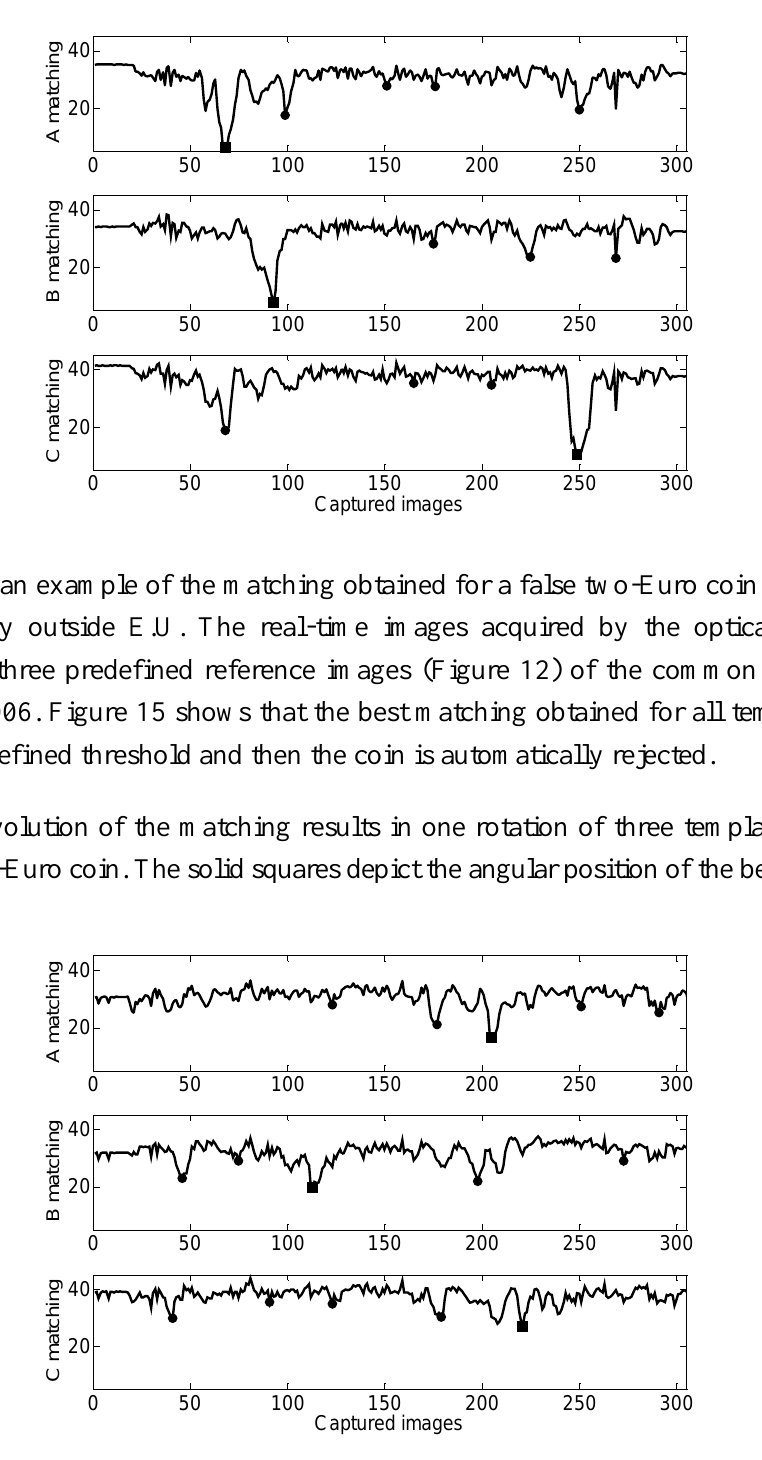
Figure 14. Evolution of the matching results in one rotation of three template images for a valid two-Euro coin. The solid squares depict the angular position of the best matching.